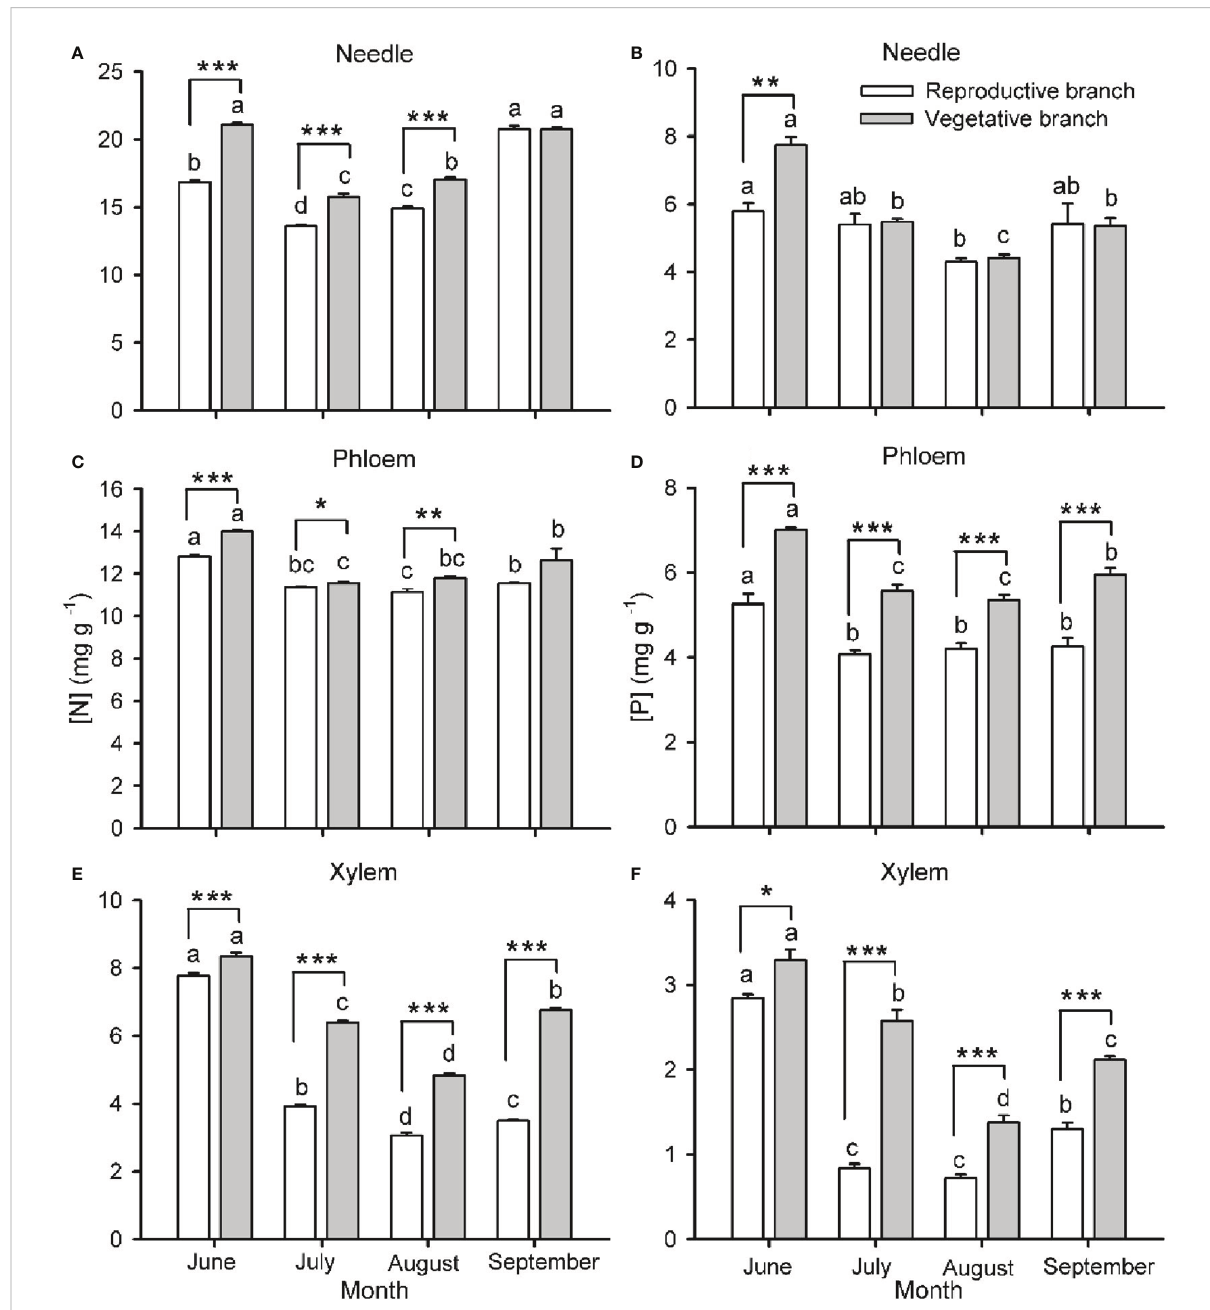
FIGURE 2 Nitrogen ( [N]; A, C, E) and phosphorus ( [P]; B, D, F) concentrations in needles (A, B) , phloem (C, D) and xylem (E, F) of one-year-old twigs of Pinus koraiensis during four sampling times (June, July, August and September, corresponding to DOYs 172, 204, 237 and 258, respectively). Bars and arrows represent the mean and corresponding standard error from fi ve trees, respectively. Asterisks indicate signi fi cant differences between branch types for a given harvest time; *, ** and *** indicate signi fi cance levels at P < 0.05, 0.01 and 0.001, respectively. Different lowercase letters indicate signi fi cant differences between harvest times for a given branch